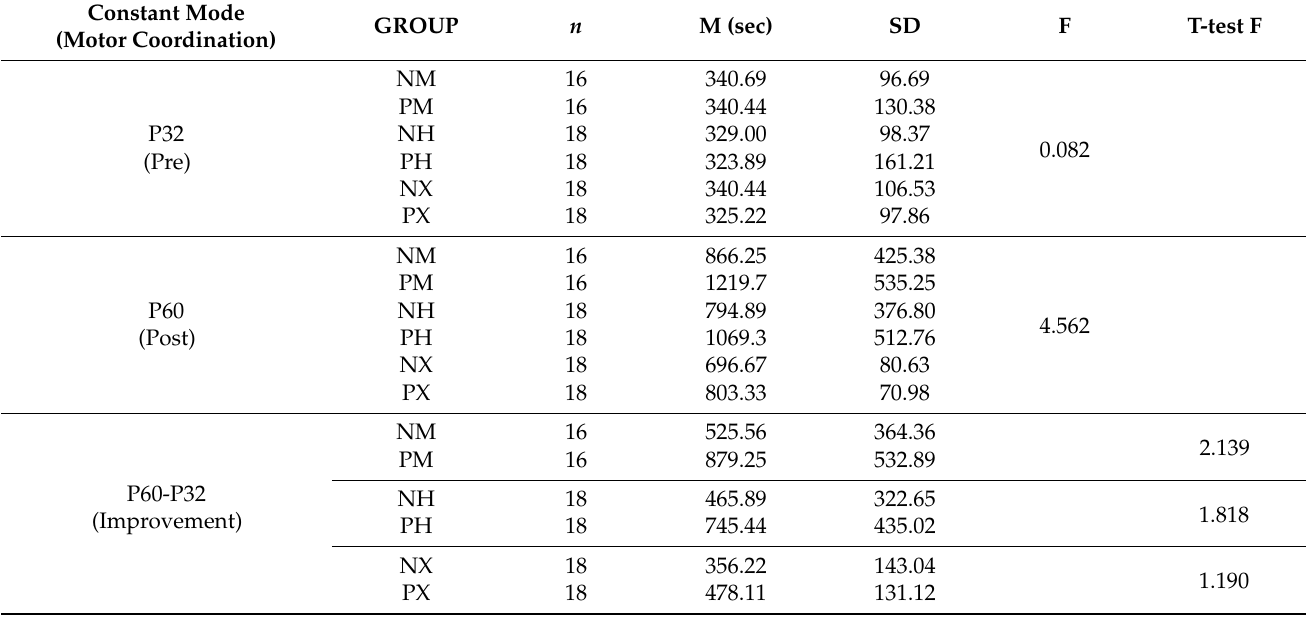
Table 2. Statistical values of latency to fall from the rotarod test at constant mode. Values are presented as M (mean, sec) and SD (Standard Deviation). At P32 and P60, significant difference was assessed by One-way ANOVA at P31 and P59. For the improvement assessment, the significant difference was evaluated by independent t -test at P60-P32. N, no probiotics;